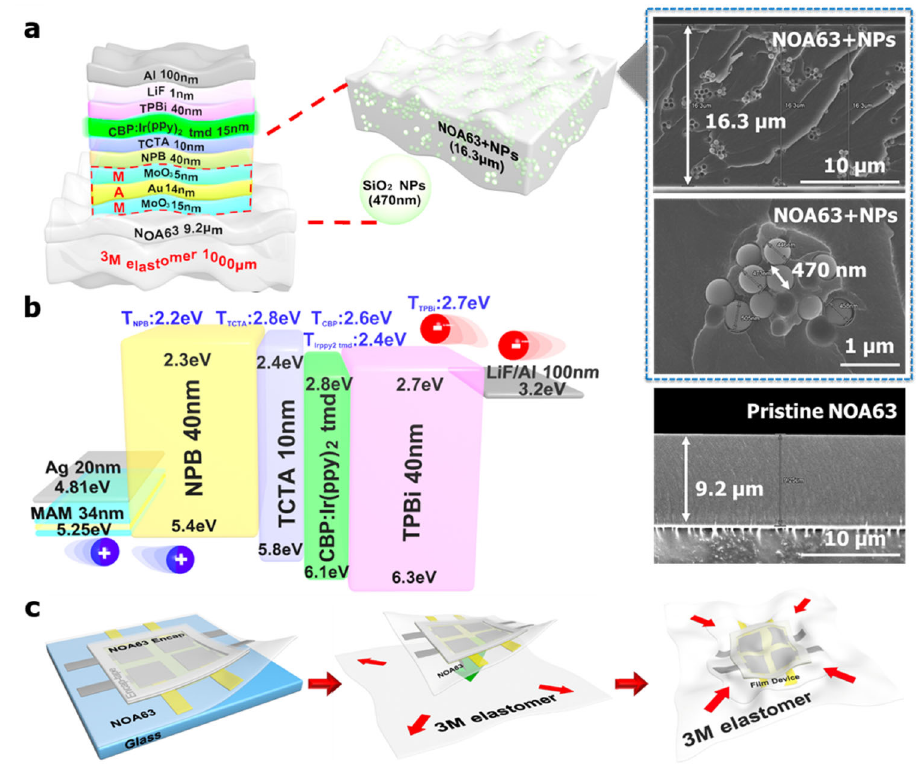
Fig. 1 Schematic illustration of the device layout and fabrication process along with the bandgap alignment. a The schematic illustration of the geometrically stretchable organic light-emitting diodes (GSOLEDs) device structure along with thickness of the layers. Extended fi gures demonstrate the thickness of the Norland Optical Adhesive 63 (NOA63) with and without silicon dioxide nanoparticles (SiO 2 NPs), size analysis of the NPs using ultra-high- resolution fi eld emission scanning electron microscopy (UHR FE-SEM). b Bandgap diagram of the layers and their triplet energy values with molybdenum trioxide (MoO 3 )/gold (Au)/MoO 3 (MAM) electrode. c Schematic illustration of the steps involved in the GSOLED device fabrication including